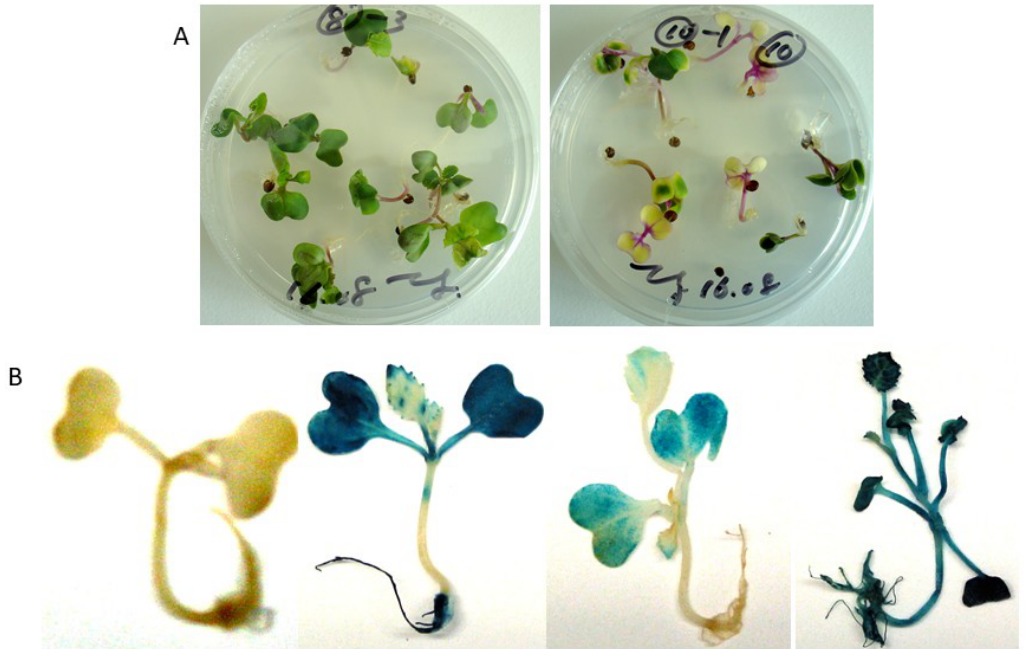
Figure 3. Selection of transgenic rapeseed plants on MS germination containing 150 mg/L kanamycin medium ( A ) and histochemical GUS staining ( B ). The healthy and green plants were used for nematode infestation in vitro and in vivo.